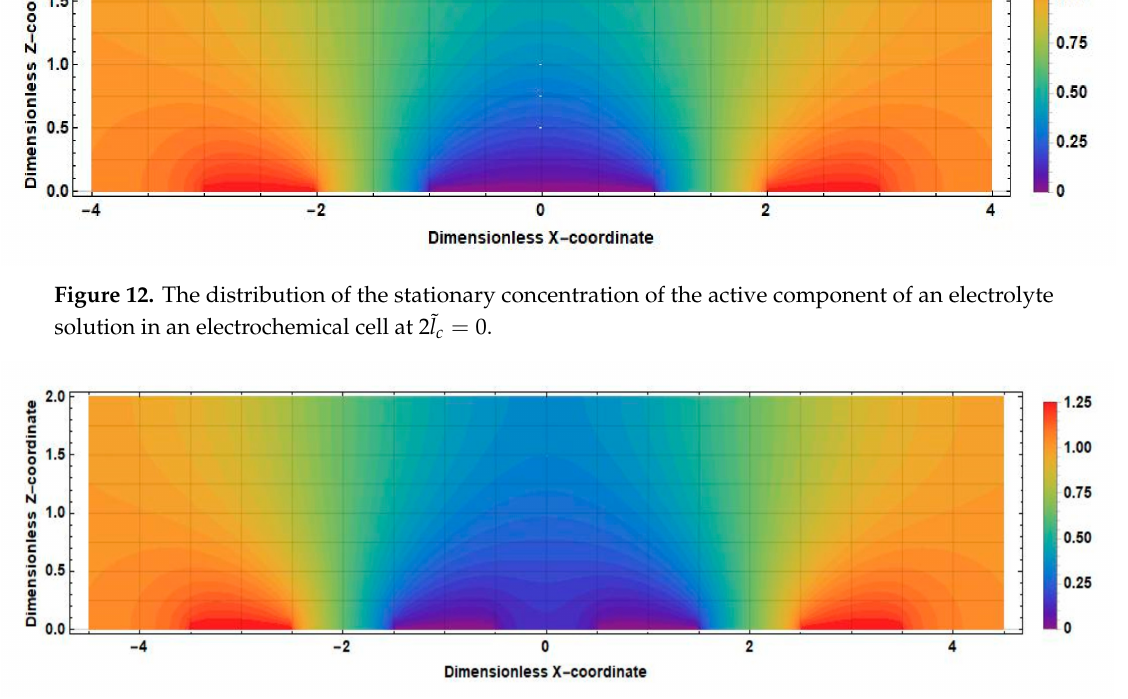
Figure 13. The distribution of the stationary concentration of the active component of an electrolyte solution in an electrochemical cell at 2˜ l c =